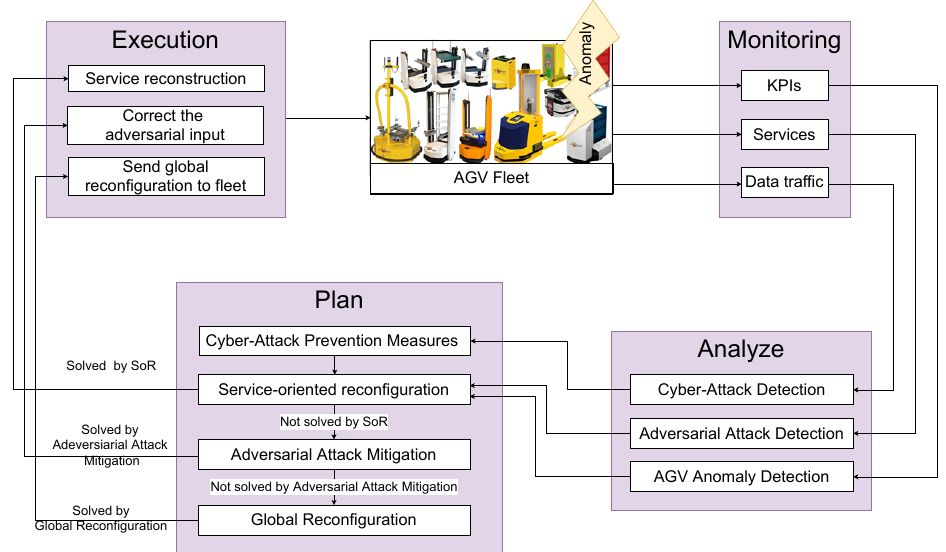
Figure 7. Anomaly detection and mitigation approach applied on the broken AGV